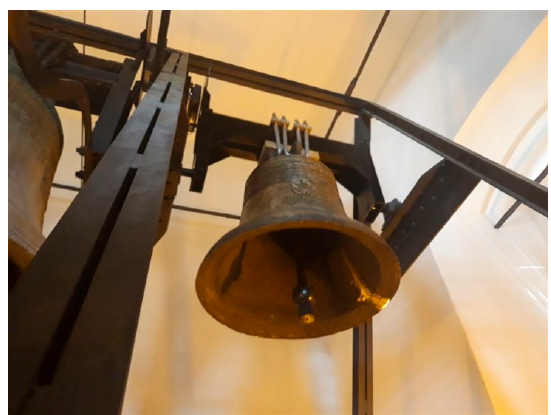
Figure 8. Welded bell attached to the tower.